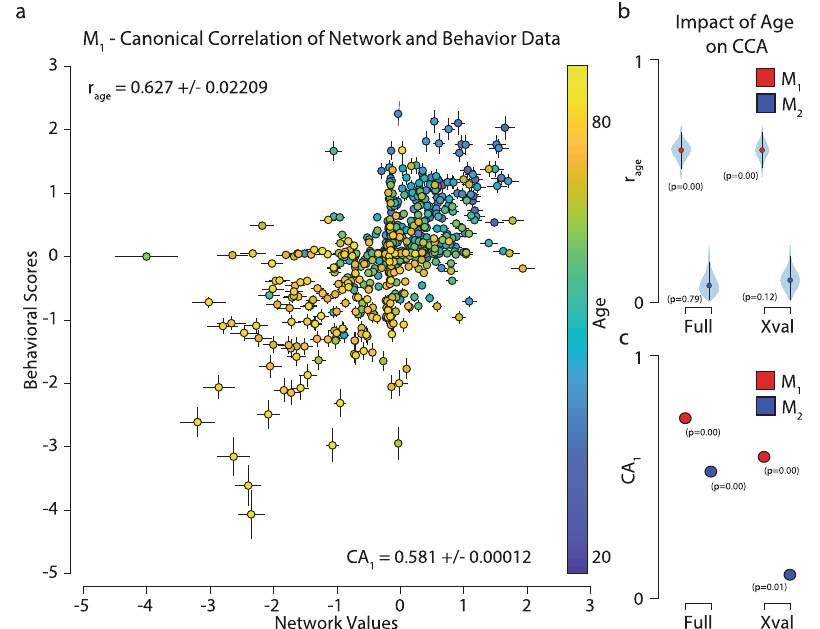
Fig. 2 Human age explains the majority of the variability in the linear association between brain networks and behavioral variables. a The fi rst canonical axis (CA 1 ) from the cross-validated model ( M 1 ). Each point represents a subject ’ s cross-validated factor score on the brain and behavior axes, respectively. Error bars represent ±3 standard error of the mean (SEM). The color of each point represents the age of the subject. The labeled correlations refer to the correlation of age to the combined canonical axis ( r age ; top) and the correlation between the two canonical axes (CA 1 ; bottom) ±3 SEM. b Association ( r age ) between the data in the fi rst canonical axis (CA 1 ) and each participant ’ s age. Violin plots show the full distribution of the observations. Statistical signi fi cance estimated by bootstrap. c Association between the brain network and behavior data for the fi rst canonical axis (CA 1 ) is shown for both M 1 and M 2 . Statistical signi fi cance estimated by